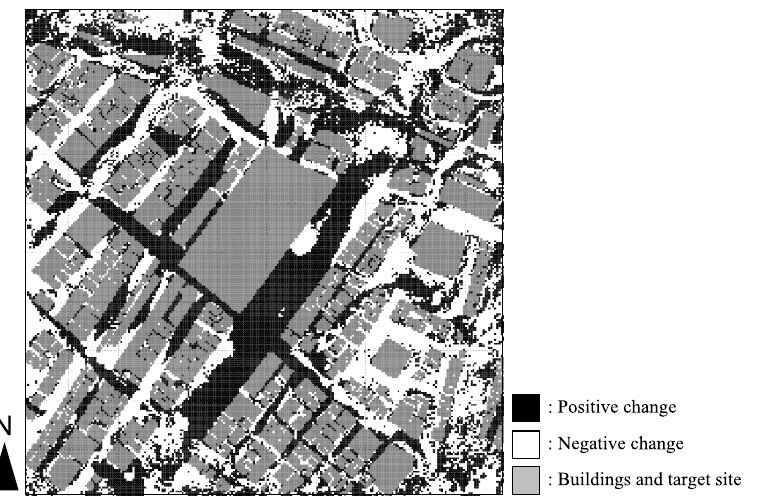
Figure 11. Change in annual average kinetic energy through design evolution (1.5 m above ground).